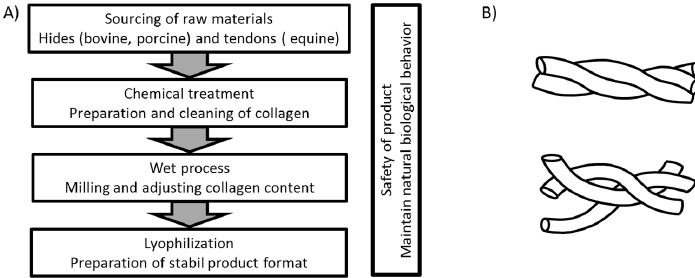
Figure 1. Collagen scaffolding. ( A ) Basic workflow for the manufacturing of collagen matrices compared in this investigation; ( B ) Top: Intact, native collagen characterized by an intact triple helix; Bottom: denatured collagen, triple helical structure destroyed.